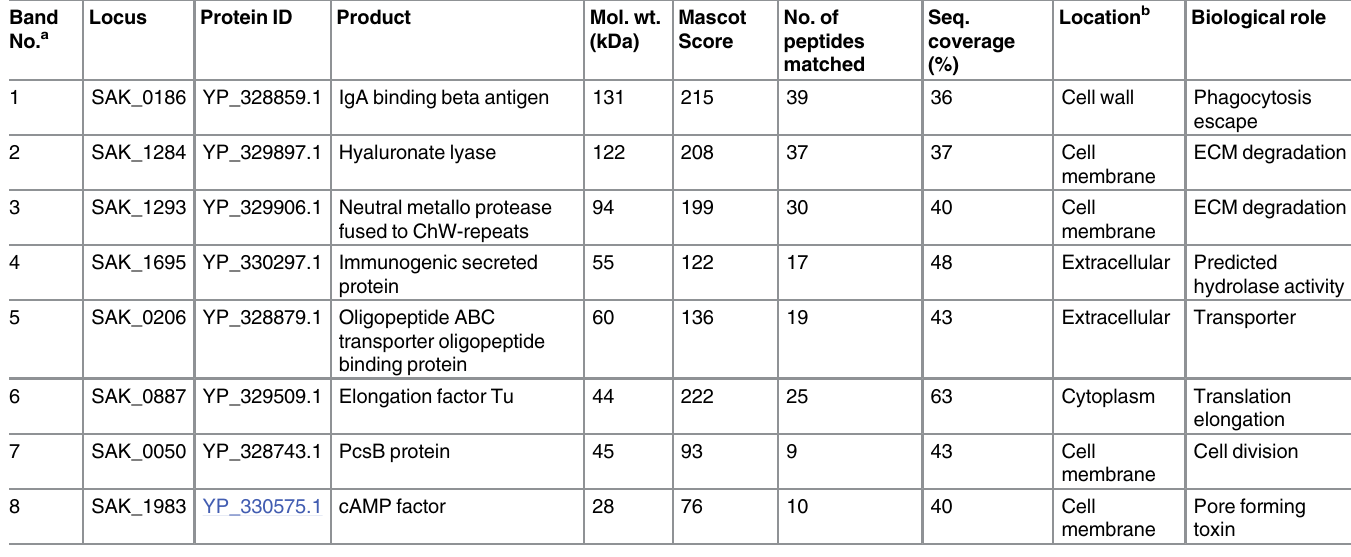
Table 1. GBS MV associated proteins and their predicted biological